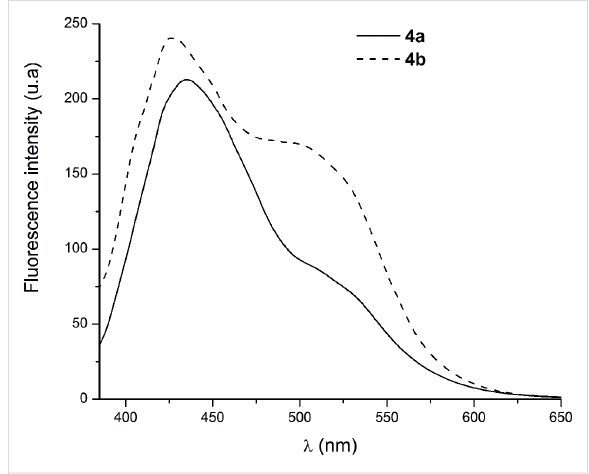
Figure 5: Emission spectra of the azulene-containing terpyridine, 4a and 4b in CH 2 Cl 2 solution (2.59 × 10 − 5 M) at room